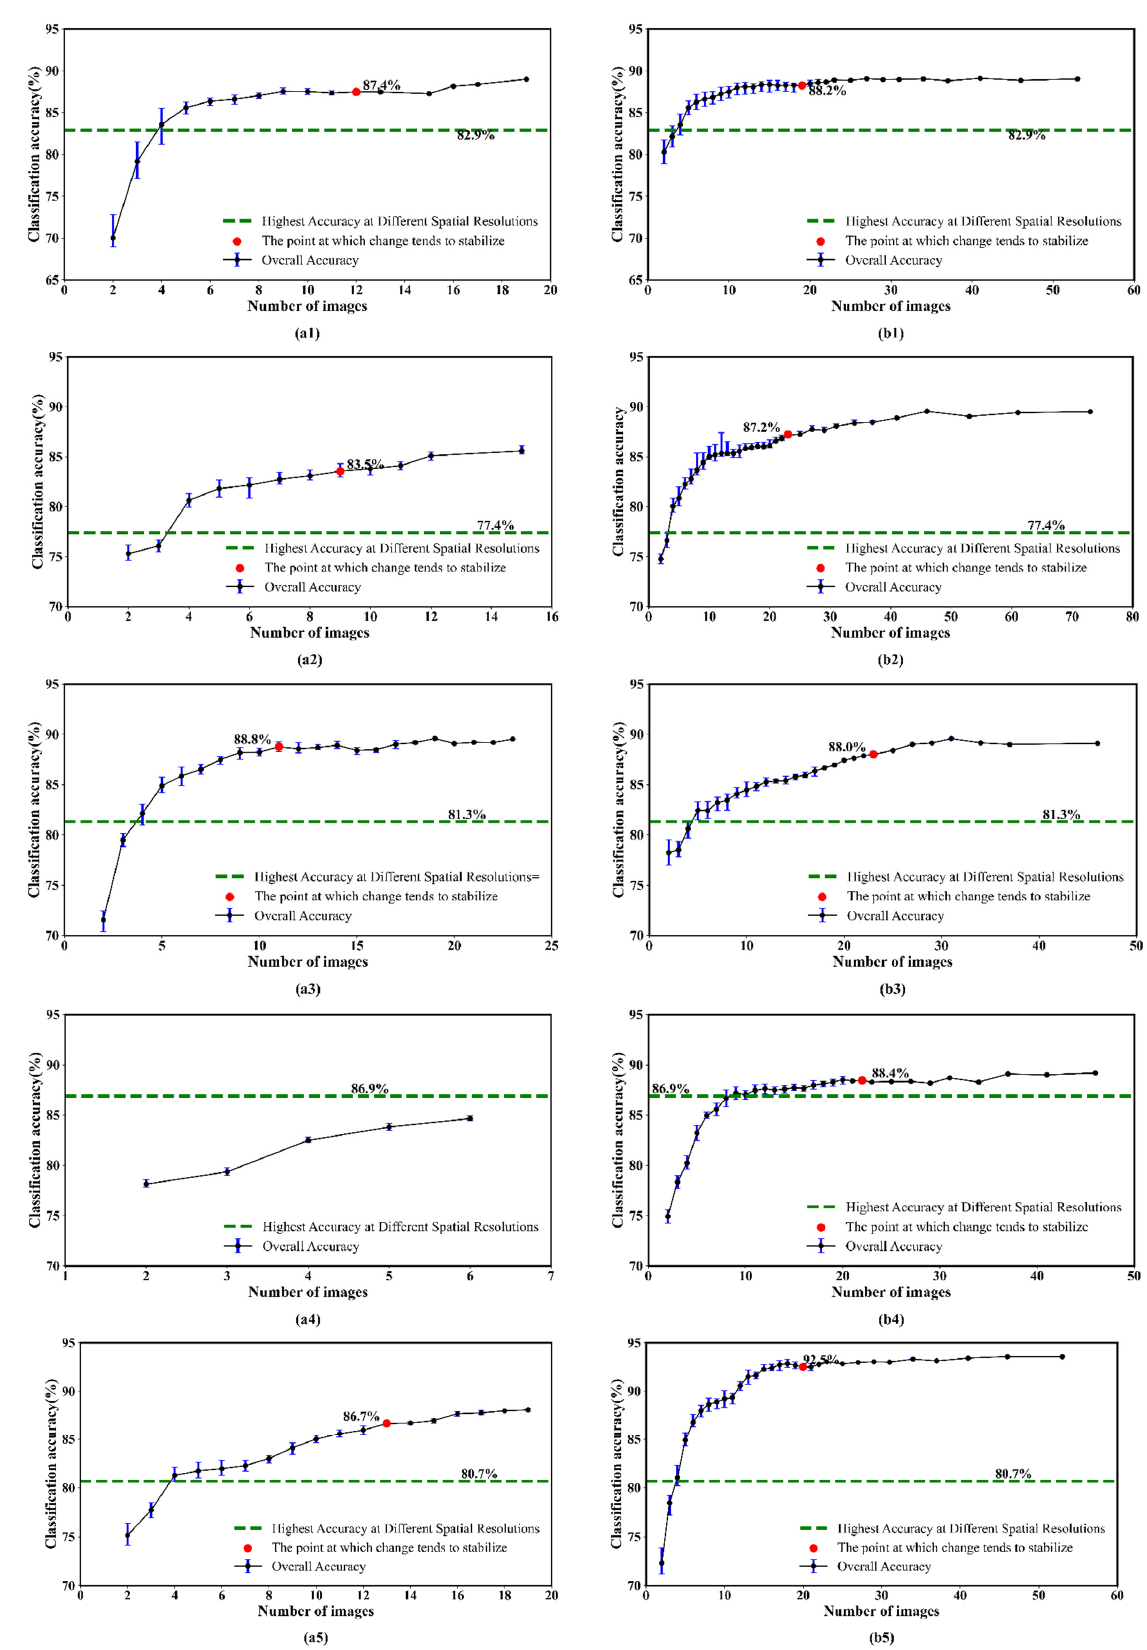
Figure 9. The relationship between the number of Landsat-8 ( a1 – a5 ) or Sentinel-2 ( b1 – b5 ) images as inputs and the OA for the five study areas.